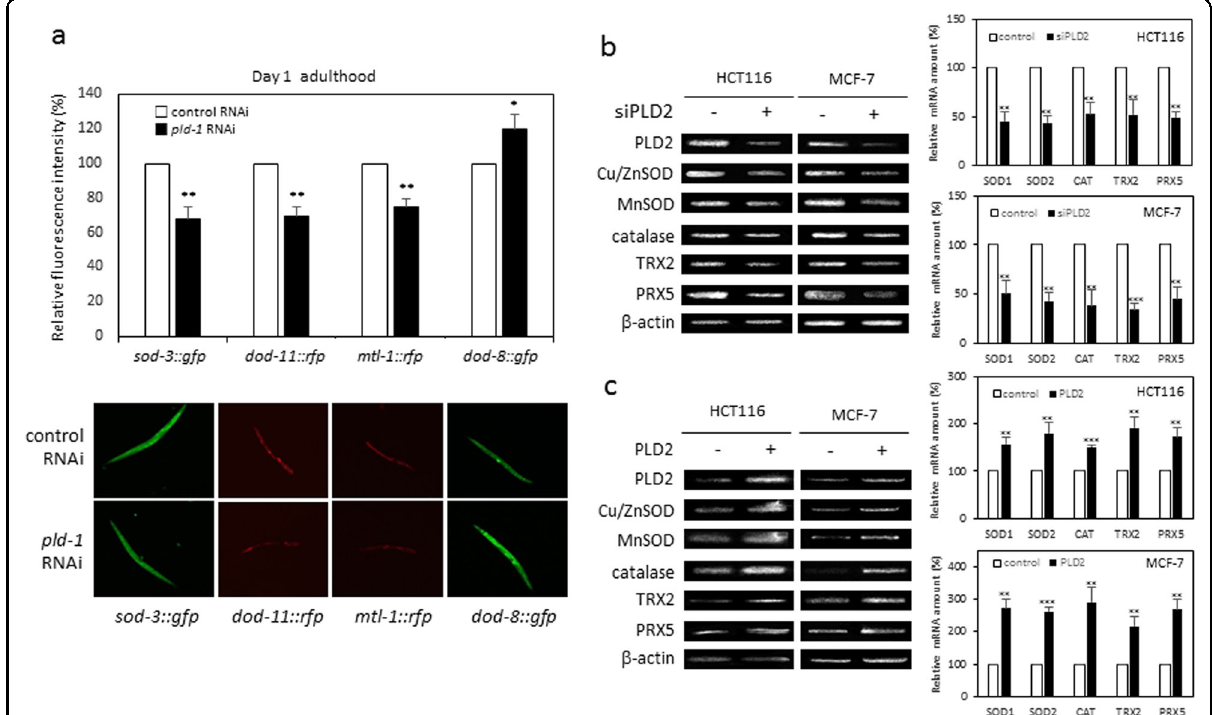
Fig. 5 PLD modulates the transcription activity of DAF-16/FoxO in nematodes and human cells. a Nematodes with integrated sod-3::gfp , mtl- 1::rfp , dod-11::rfp , and dod-8::gfp reporter constructs were fed with control RNAi or pld-1 RNAi at L4 stage for 1 day. Fluorescence intensity of GFP and RFP (upper panel) was quanti fi ed using ImageJ software by determining the average pixel intensity ( n > 111 per condition). Data are shown as the means ± SEM. * P < 0.05; ** P < 0.01. Representative fl uorescence images at day 1 of adulthood were obtained at 10× magni fi cation (bottom panel). b , c PLD2-modulated transcriptional activity of FoxO3a in human cells. HCT116 and MCF-7 cells were treated with PLD2 siRNA ( b ) or pcDNA-PLD2 ( c ) for 48 h. Total RNA was extracted from the cells, and then RT-PCR was performed using speci fi c primers for PLD2, Cu/ZnSOD (SOD1), MnSOD (SOD2), catalase, thioredoxin-2 (TRX2), and peroxiredoxin-5 (PRX5). PCR products were resolved on a 1.5% agarose gel (left panel). β -actin was used as an internal control. Representative data from three independent experiments are shown. The graphs show the relative transcription levels of these antioxidant genes (right panel). Data are shown as the means ± SEM. ** P < 0.01; *** P <